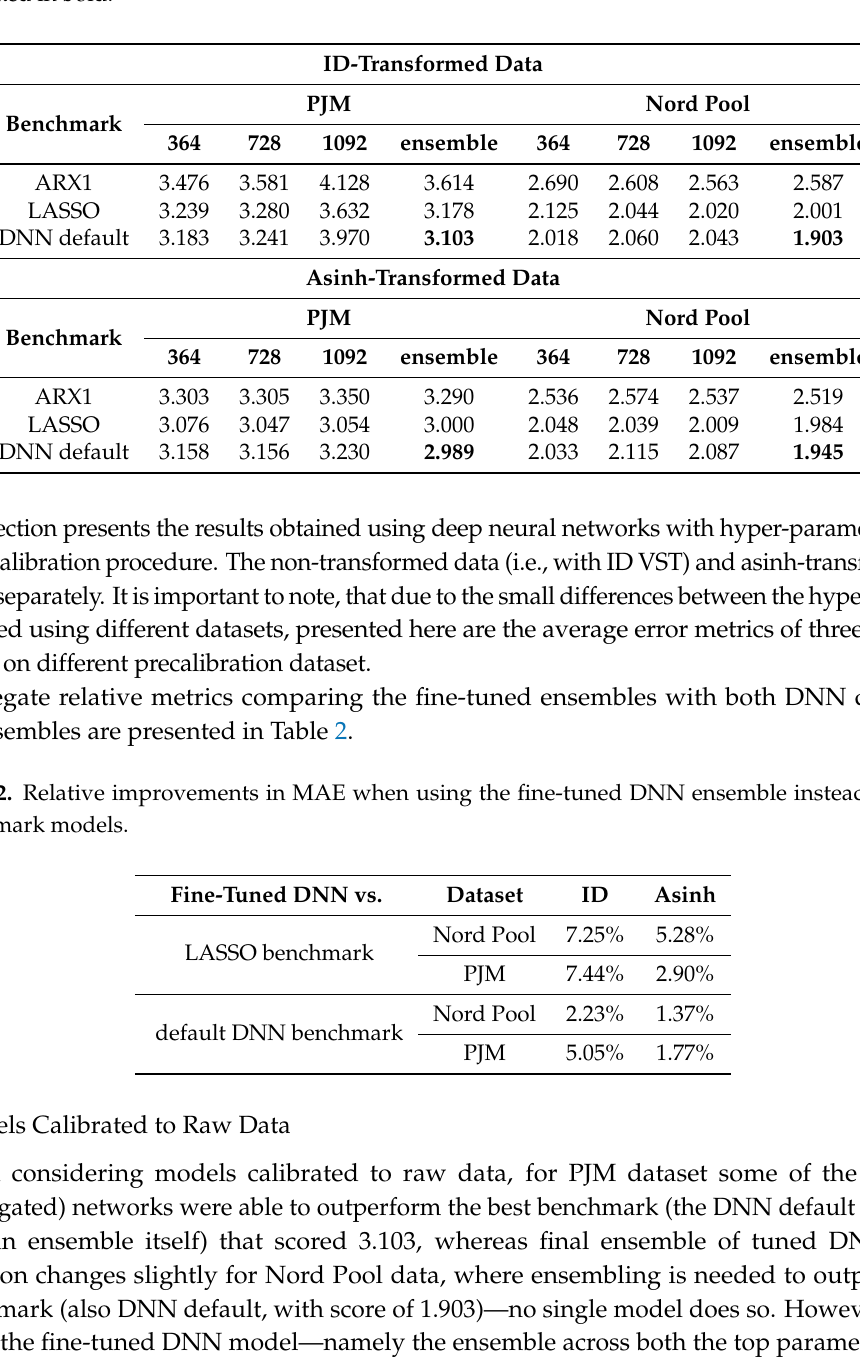
Table 1. Mean absolute errors for the benchmarks. The lowest score for each of the VSTs and datasets is marked in bold.